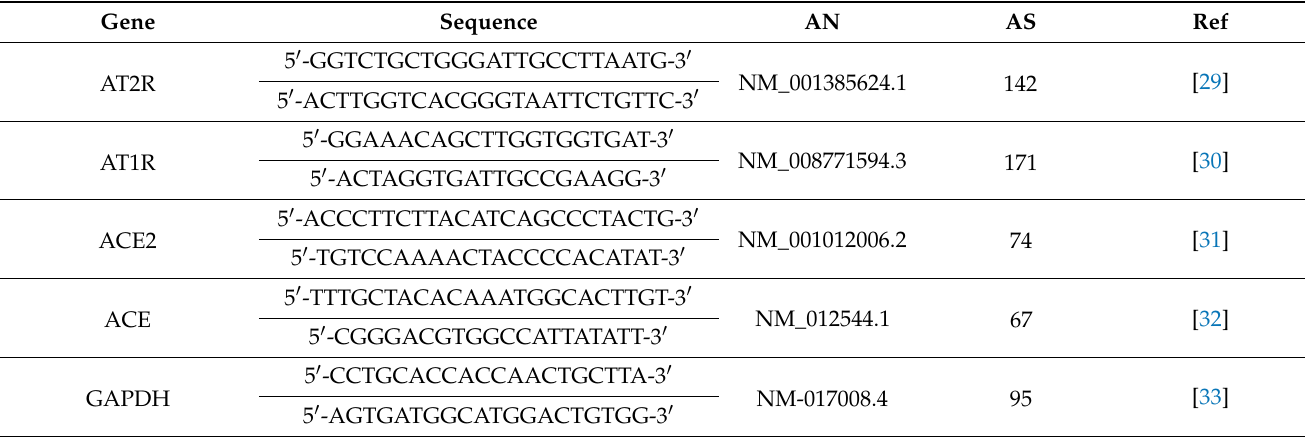
Table 1. Primer sequences of genes with the accession number and amplicon